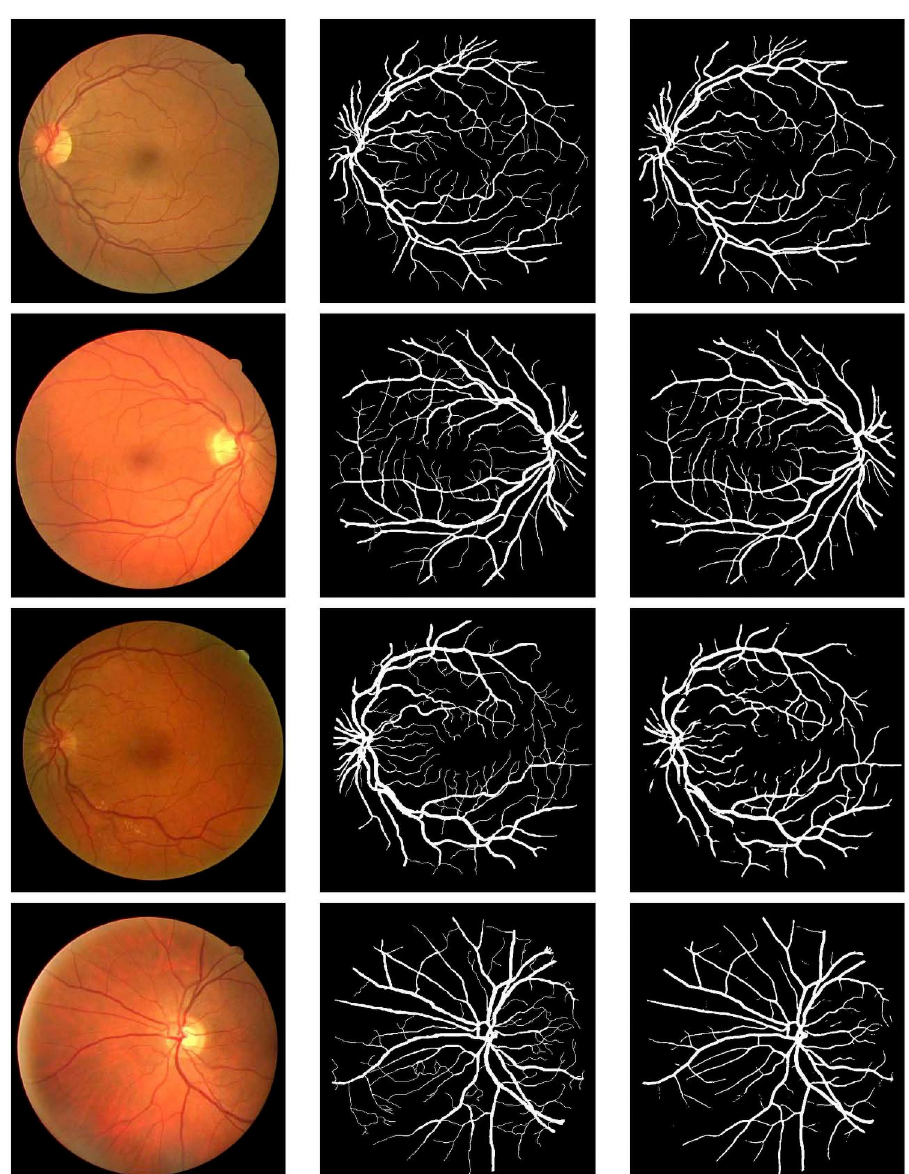
Fig 5. Visual results on the DRIVE dataset. From left-to-right: input images, ground truth, result obtained by our proposed method.